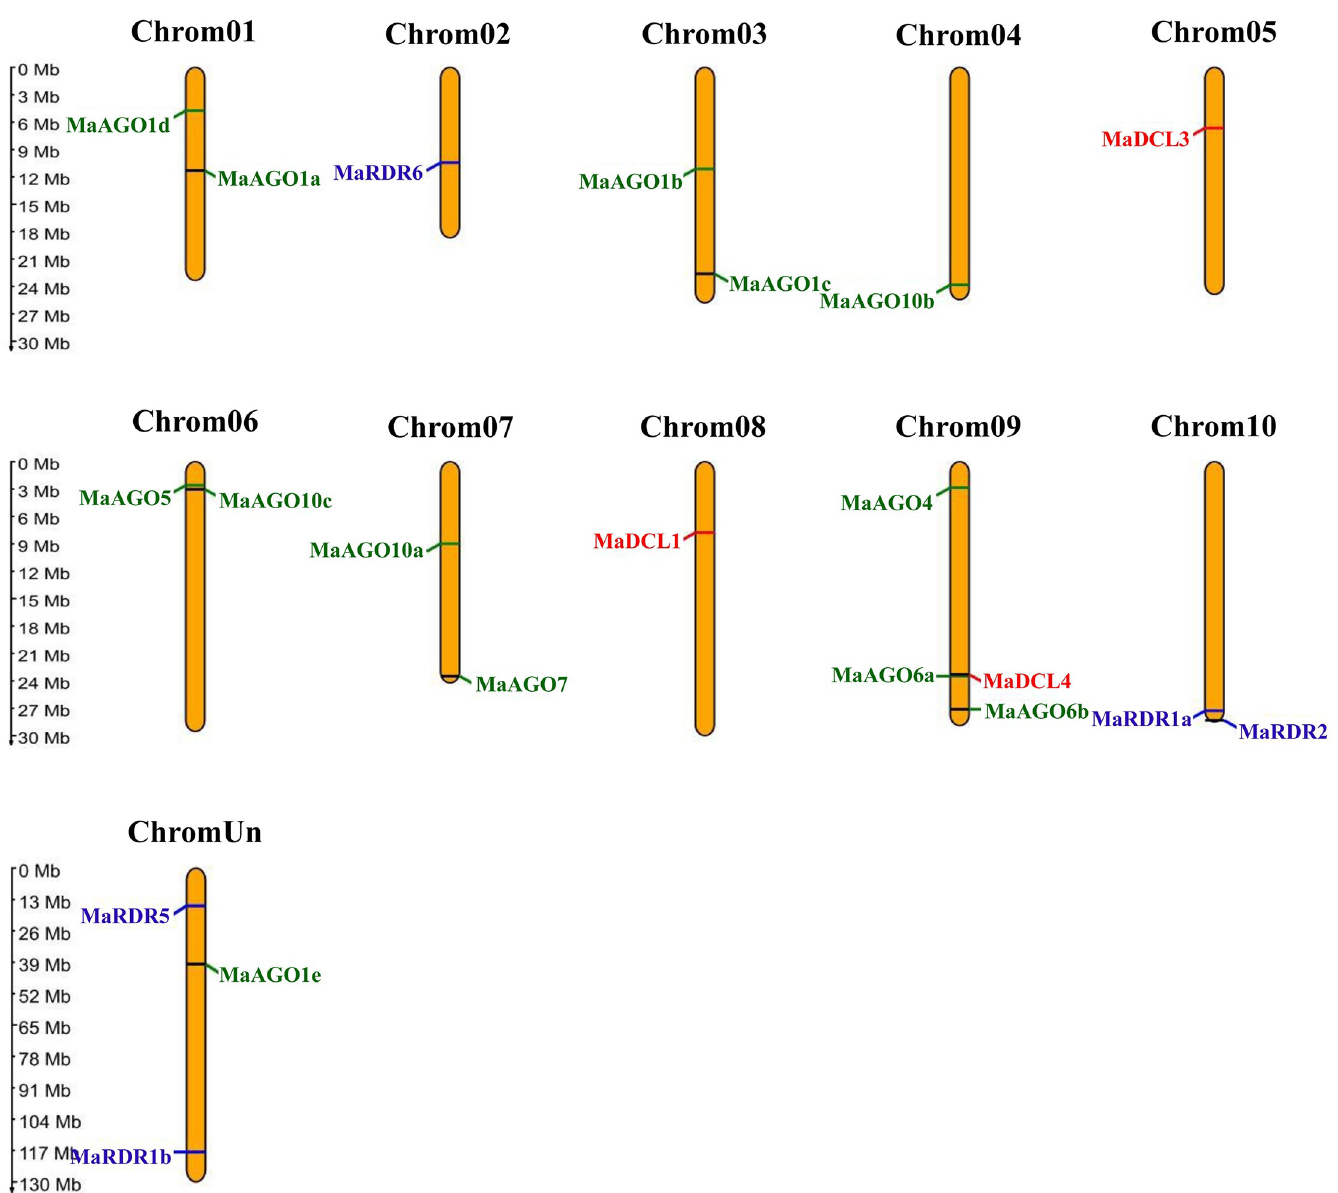
Fig 9. The genomic location of the predicted MaDCL, MaAGO, and MaRDR genes. The scale to indicate the chromosomal length is provided on the left. The ChrUn means the unknown chromosome.